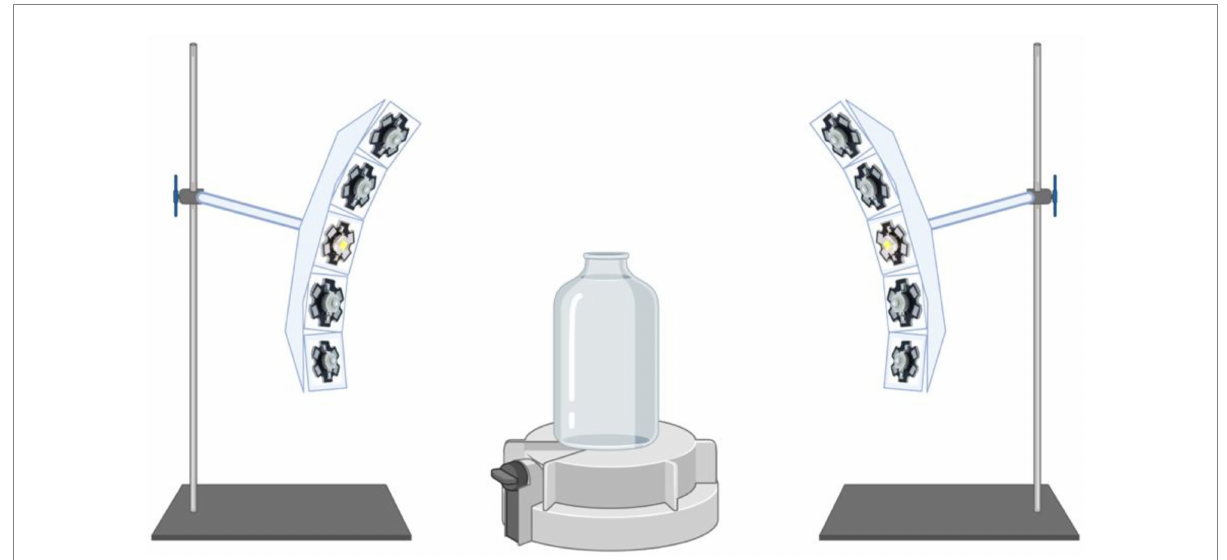
FIGURE 1 Schematic of the illumination apparatus. Cool LED polychromatic light sources are shown to be directed toward the glass bottle via collimating lens to focus the emitted light down to a 5 degree beam; Light meter (Apogee Instruments) located at the bottom of the glass bottle is